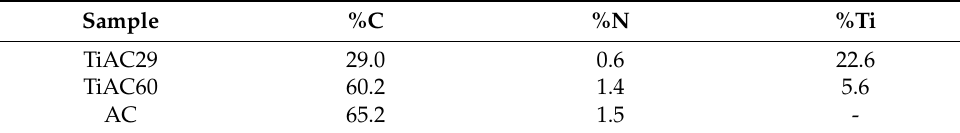
Table 1. Results of chemical analyses (weight %) of the AC and TiACX materials. Sample %C %N %Ti